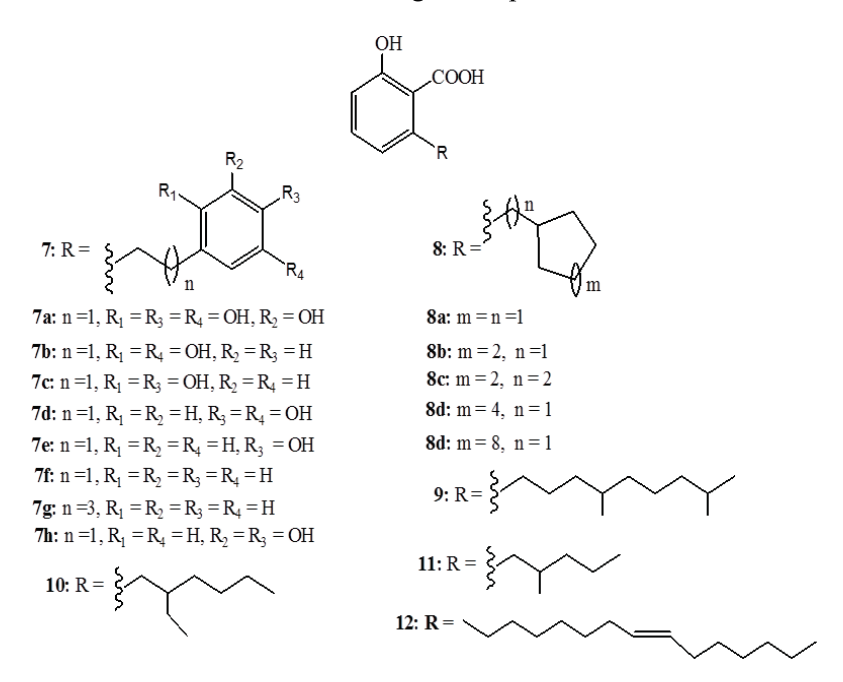
Figure 4. The synthetic anacardic acids ( 7 – 12